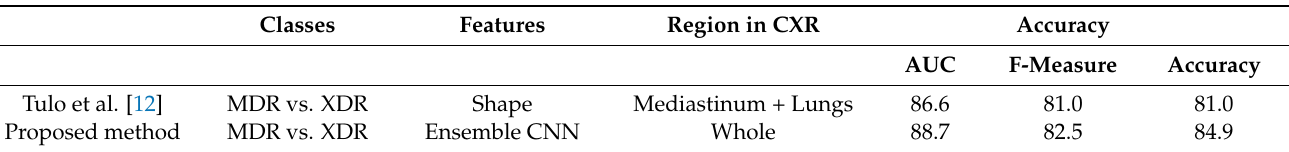
Table 11. The accuracy of the proposed methods with the existing heuristics to classify MDR and